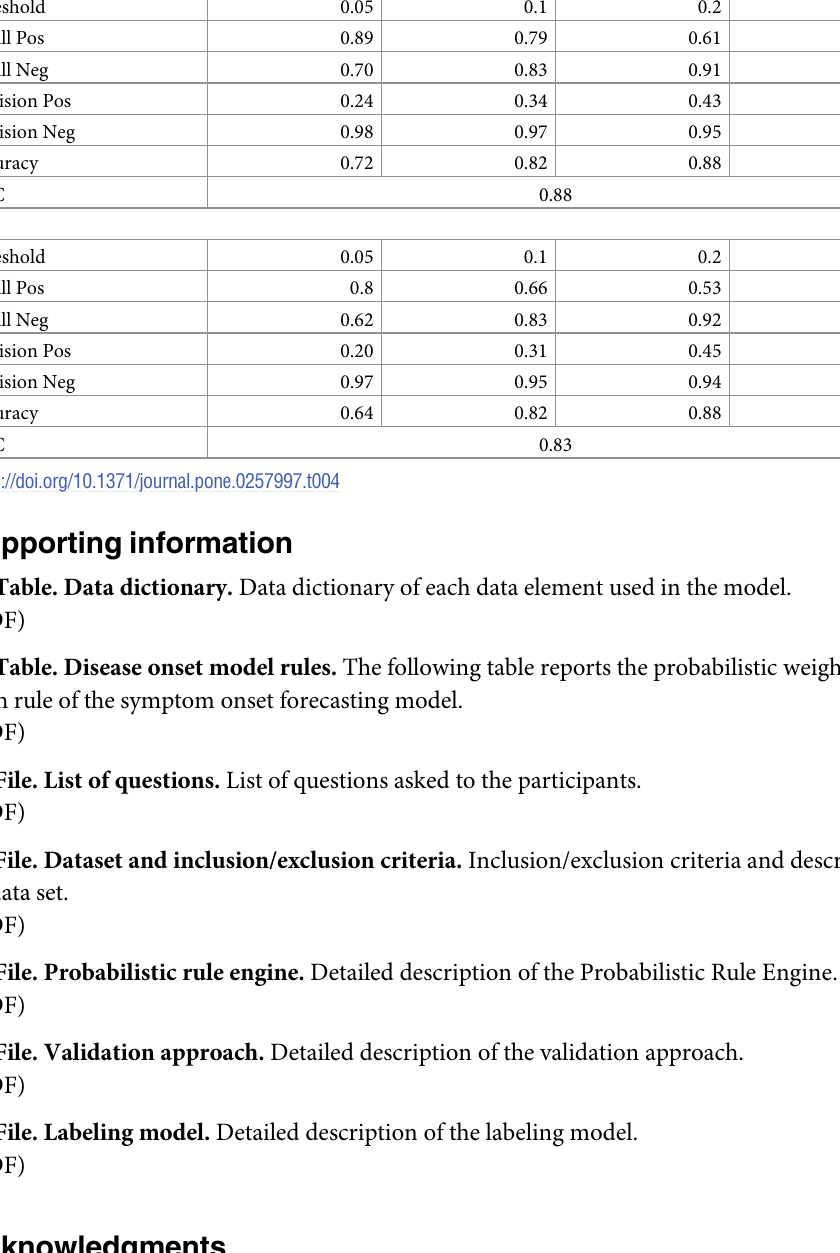
Table 4. Model performance with and without PVT. A. With PVT. B. Without